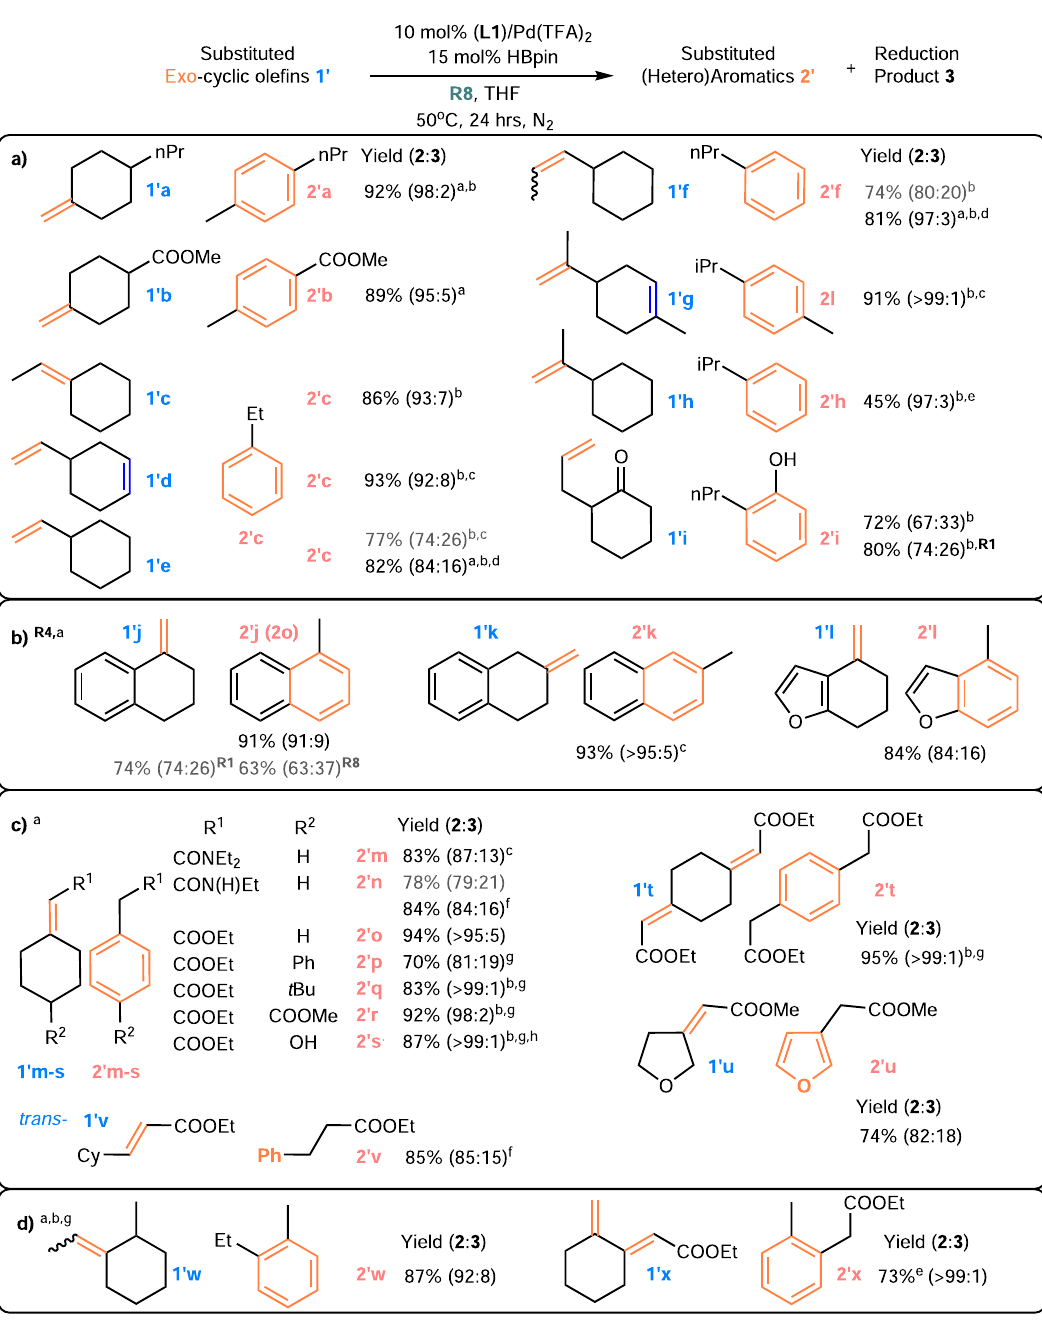
Fig. 5 | Exocyclic ole fi n 1 ′ transfer-dehydroaromatization. a Aliphatic exocyclic ole fi ns. b Fused aromatic rings. c Exo-conjugated systems. d Unsymmetric cycloi- somerization products. Standard conditions: The ole fi n (0.25mmol), L1 /Pd(TFA) 2 catalyst (0.025mmol), HBpin (0.0375mmol), and R8 (0.5mmol) were stirred in 2mL of THF for 24h at 50°C, unless otherwise indicated. The yields of 2 and 2 : 3